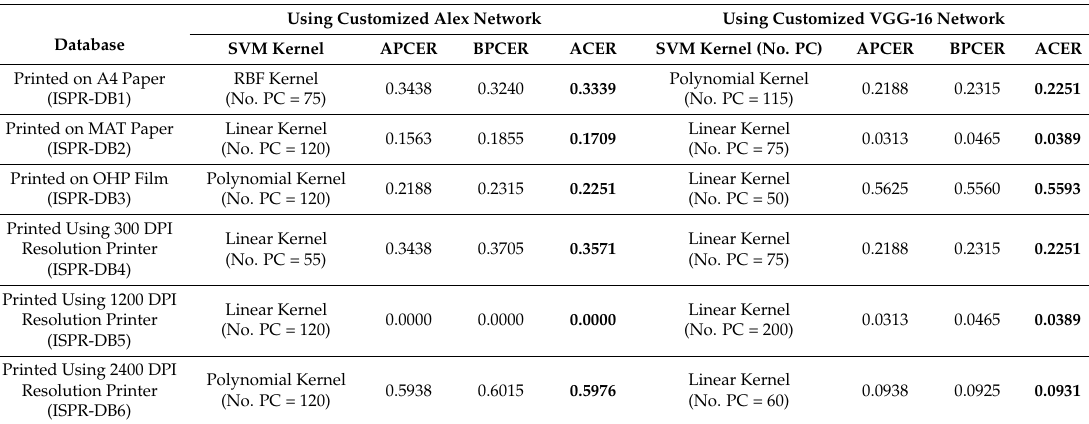
Table 20. Detection errors of our proposed method using customized Alex network and VGG-16 network on sub-databases of ISPR-DB database (unit: %).